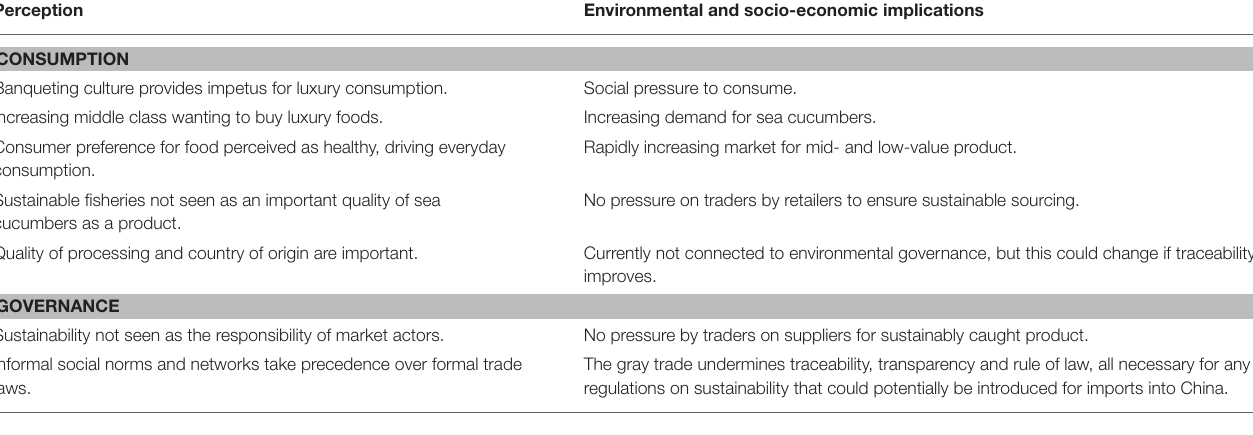
Rapidly increasing market for mid- and low-value product. No pressure on traders by retailers to ensure sustainable sourcing.